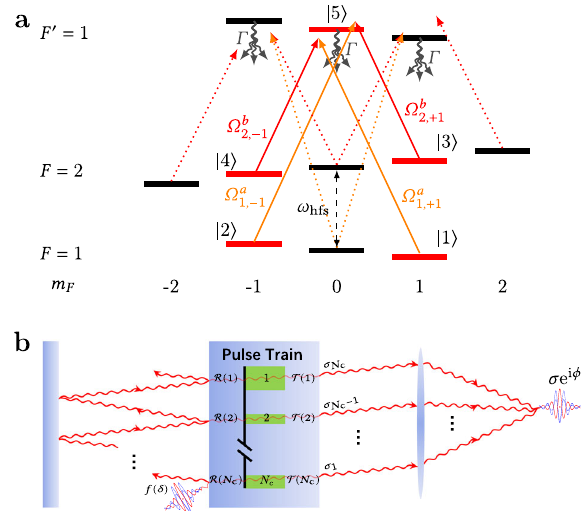
Fig. 1 Schematic diagram. a Energy levels of 87 Rb D 1 line transitions under the lin ∣∣ lin con fi guration. The black and red lines, respectively, denote two independent six-level and fi ve-level and Ω b are the Rabi frequencies of fi ve-level subsystems. Ω a 1 ; ±1 2 ; ±1 subsystems, Γ is the decay rate from excited states to ground states, and ω hfs is the zero- fi eld hyper fi ne splitting of the ground state. 1 j i , 2 j i , 3 j i , and 4 j i are four ground states of fi ve-level subsystems. b The temporal analog of FPR, σ denotes the form of spin coherence, N c is the total number of CPT pulses. The l -th CPT pulse, which corresponds to the ( N c − l + 1)-th re fl ection event with the re fl ection coef fi cient Rð l Þ and the transmission coef fi cient T ð l Þ , transmits σ σ N c (cid:2) l þ 1 , which is part of